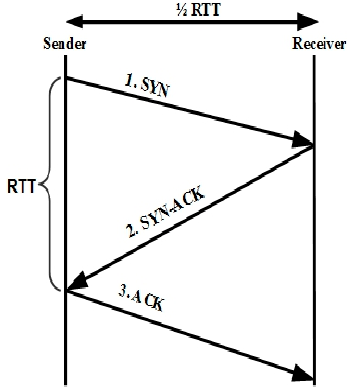
Figure 1. TCP RTT sample calculation.